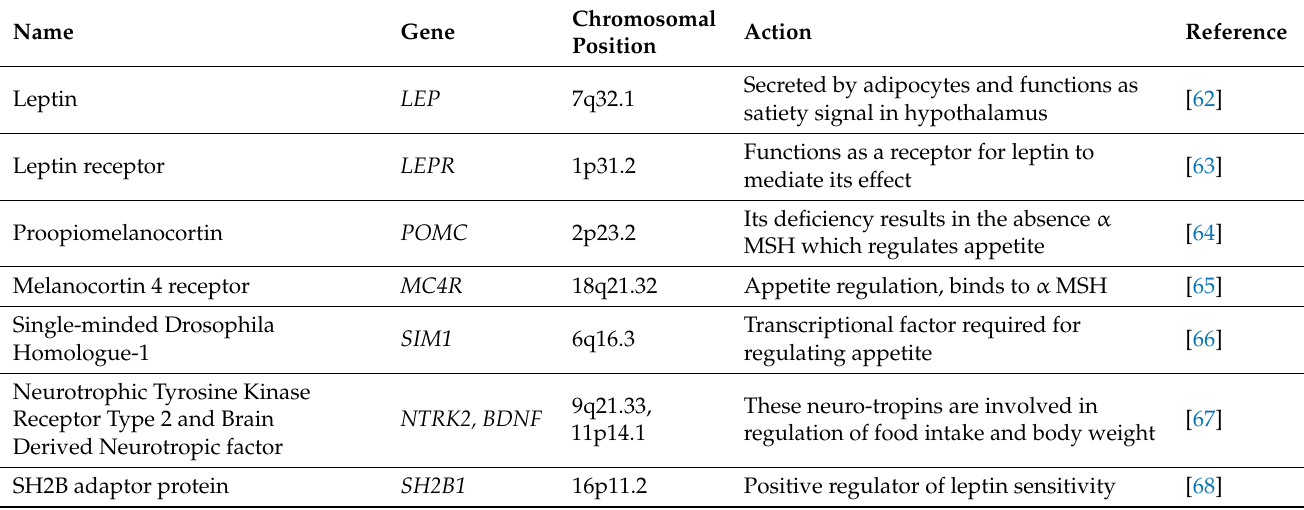
Table 2. Monogenic mutations linked to